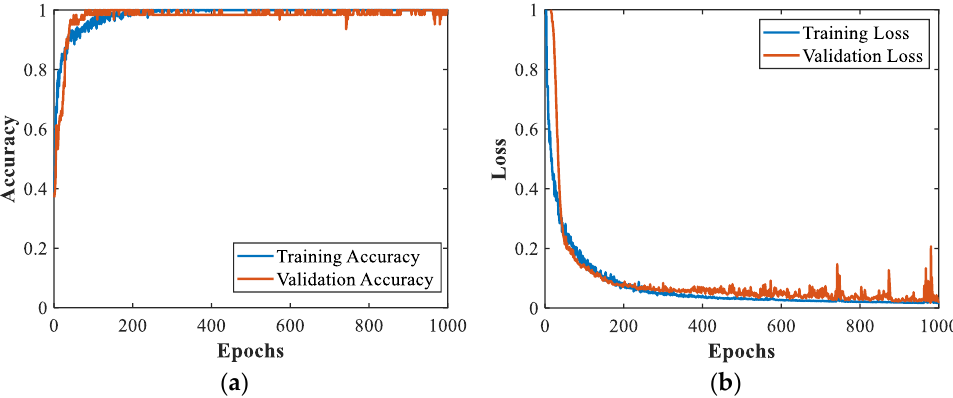
Figure 7. ( a ) The change curves of accuracy during 1D CNN training process. ( b ) The change curves of loss during 1D CNN training process. of loss during 1D CNN training